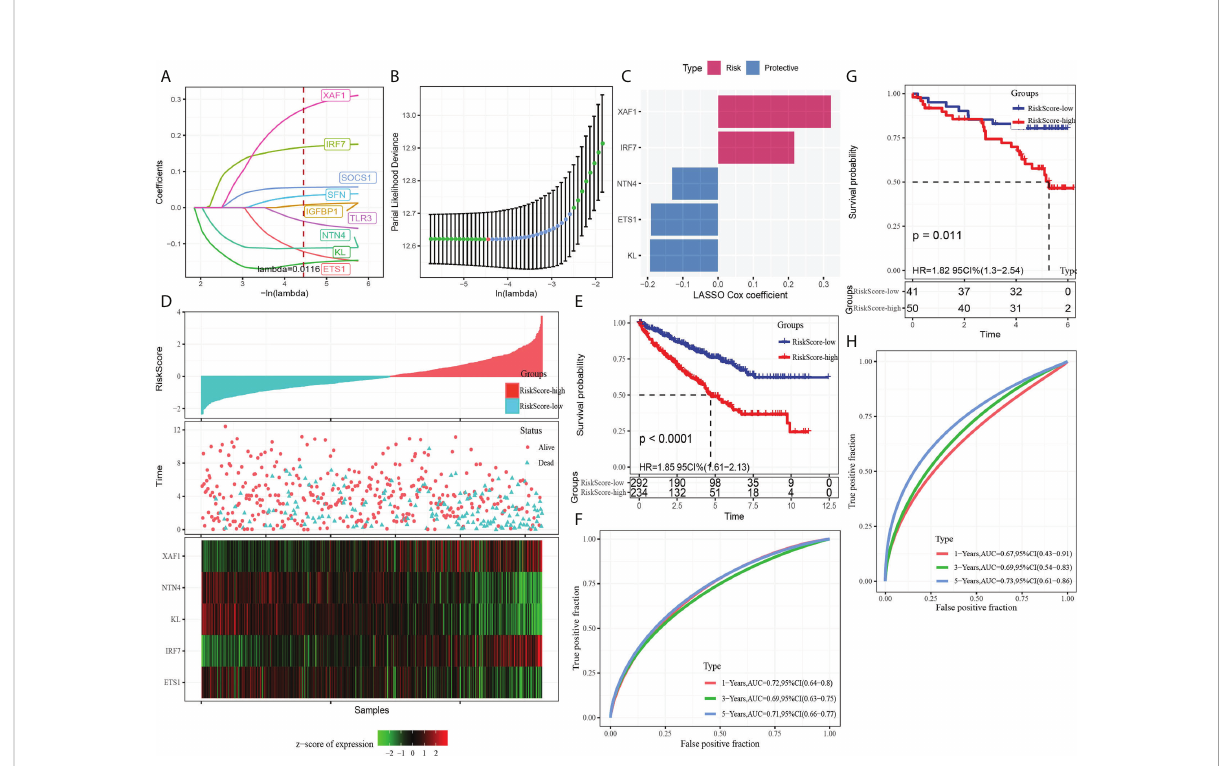
FIGURE 5 Establishment and veri fi cation of the CS-related risk model. (A) The LASSO coef fi cient curves of nine CS-related genes. (B) Ten-fold cross- validation of adjusting parameter selection in LASSO regression. (C) LASSO Cox coef fi cient of the fi ve genes. (D) The arrangement of risk score, the depiction of survival status, and the expression trend of fi ve genes in the samples of TCGA-KIRC dataset. (E) Kaplan – Meier curve of survival of the high-risk group and low-risk group in TCGA-KIRC. (F) The ROC curve showed the AUC of risk score predicting the survival of patients in TCGA-KIRC. (G) The Kaplan – Meier curve depicts the survival trend of high-risk and low-risk patients in ICGC datasets. (H) The ROC curve for patients OS in ICGC was predicted by the risk